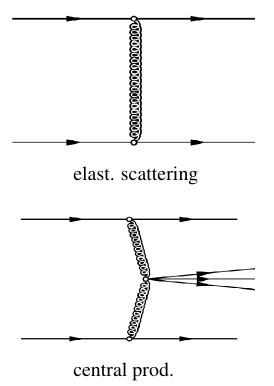
Figure 1. Di ff ractive event